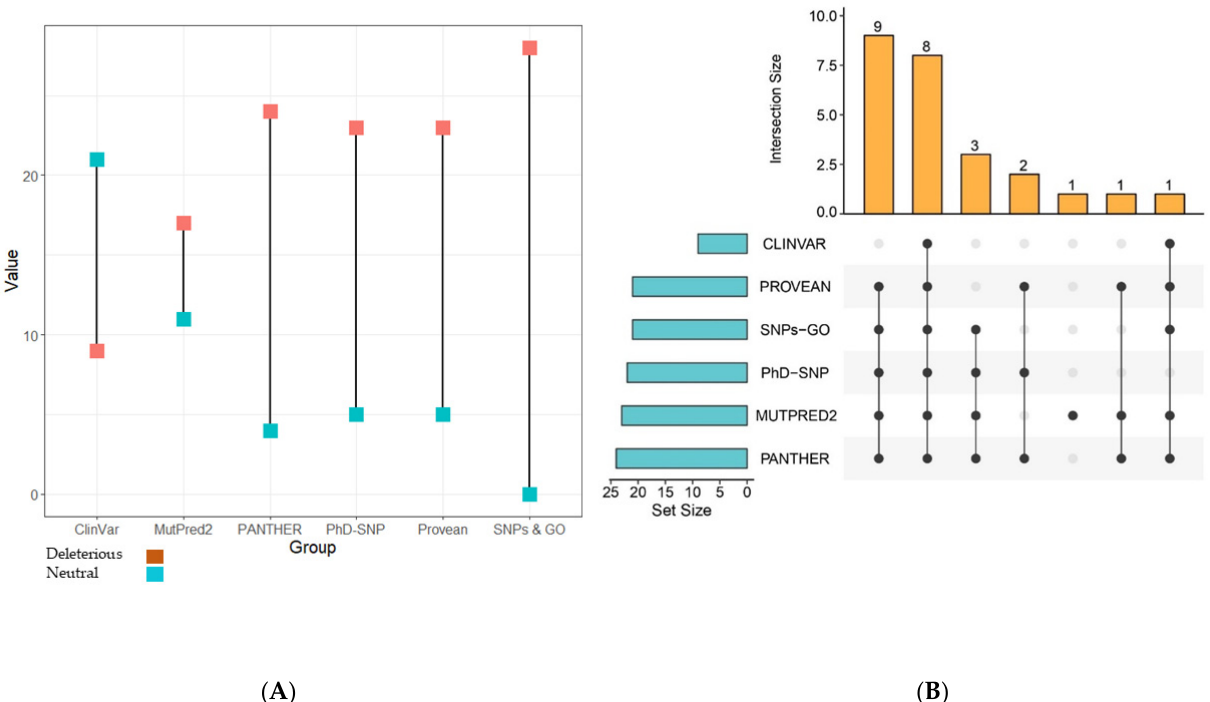
Figure 2. ( A ) Number of nsSNPs predicted through different Insilco tools that are described as deleterious or neutral in two different colors. ( B ) Upset plot describing a different number of deleterious nsSNPs predicted by the tools. Eight nsSNPs were predicted as deleterious by six Insilco tools. Here, connecting dots represent a combination of the tools that predicted deleterious SNPs.